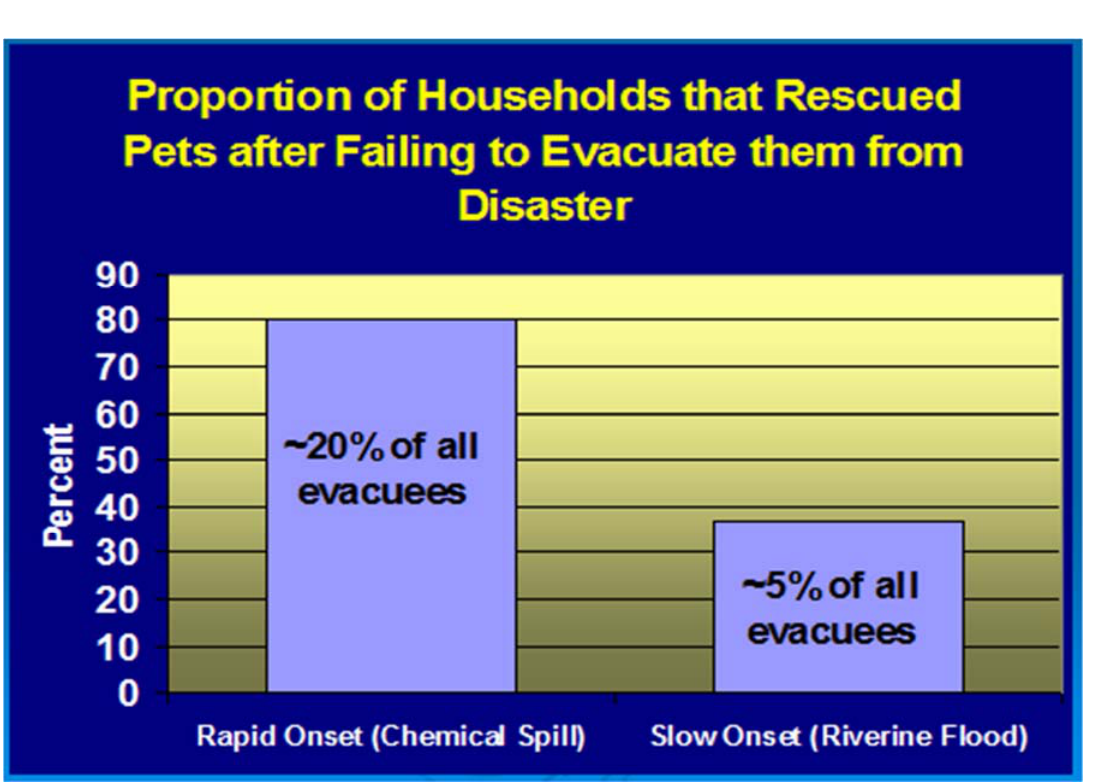
Figure 6. Proportion of all evacuated households that attempted to rescue pets after the owners evacuated without their pets from a slow and a rapid onset disaster owners evacuated without their pets from a slow and a rapid onset disaster [28].